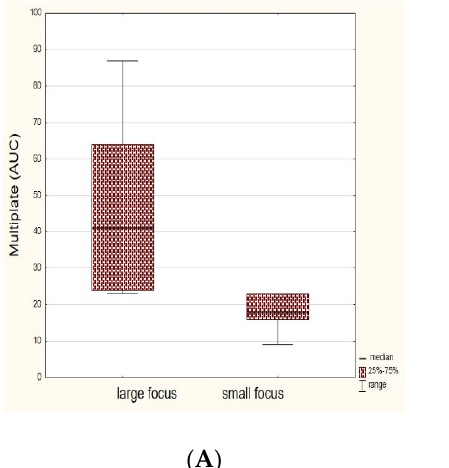
Figure 4. Comparison of ischemic focus size (in mL) in the di ff usion-weighted imaging (DWI) sequence in the group of patients resistant and sensitive to Aspirin (ASA) in the large artery atherosclerosis subgroup ( A ) and the small-vessel disease subgroup ( B ).